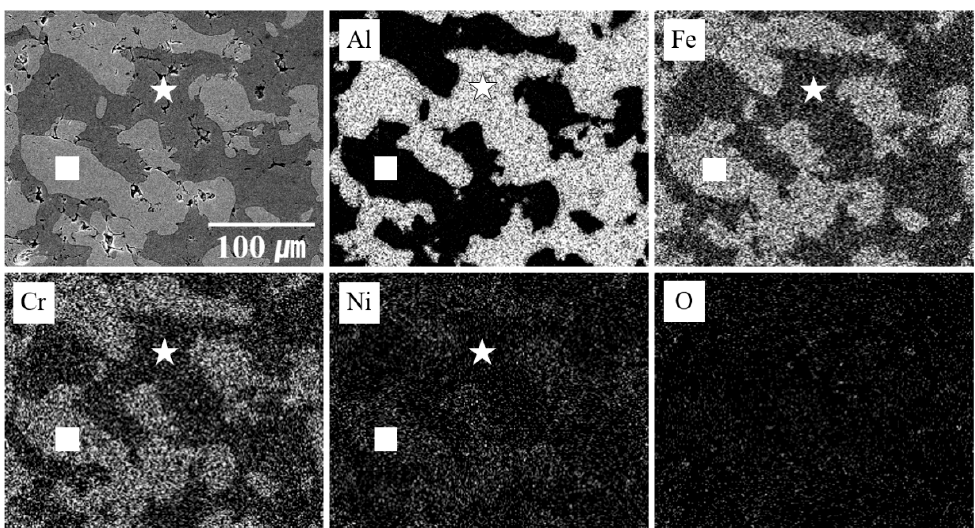
Figure 7. EDS micrographs of Al-50 vol.% SUS316L composite material (inset: □ = SUS316L phase, ☆ = intermetallic compounds).